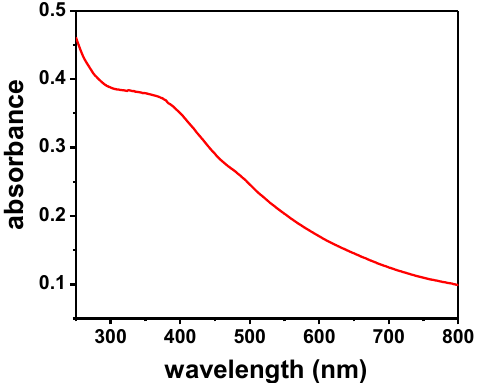
Figure 5. UV-Vis absorption spectrum of an aqueous solution of MPA-stabilized Fe 3 O 4 @Au pNPs.